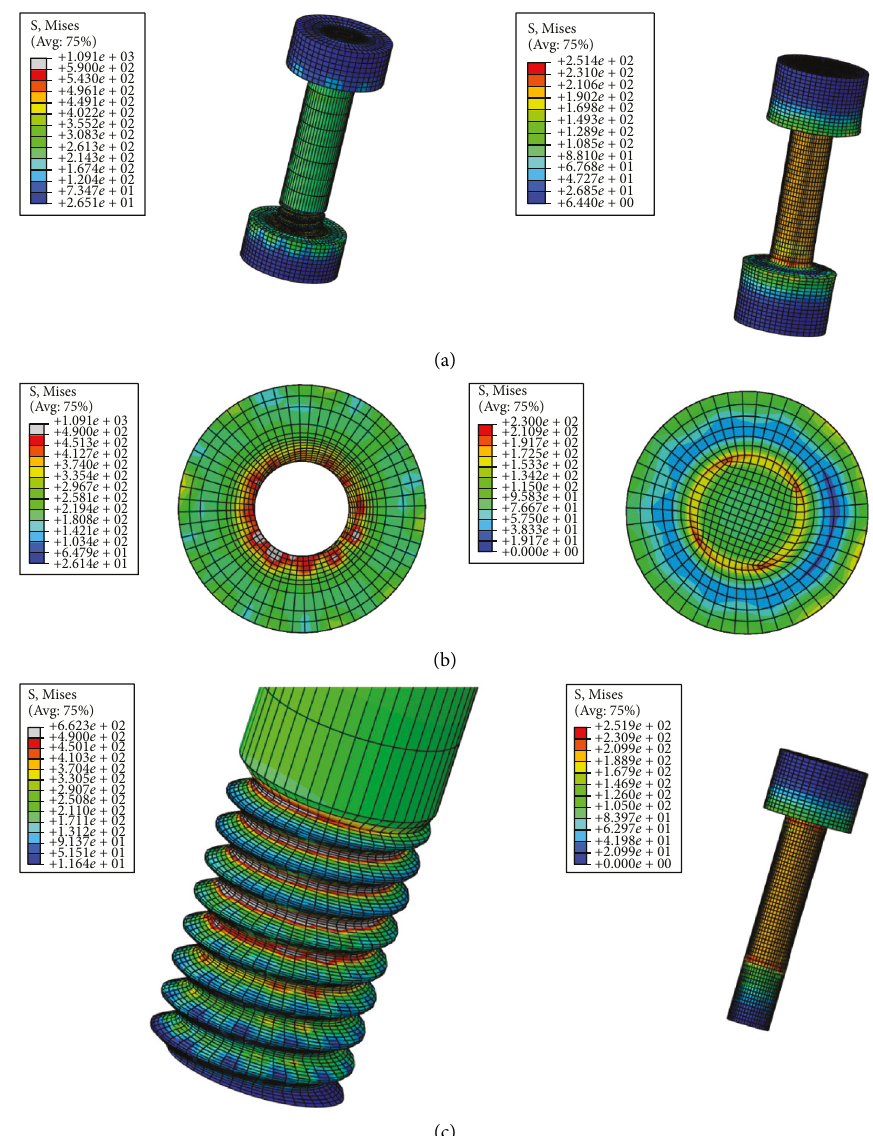
Figure 7: Stress comparison of two different preloaded models. (a) Overall bolt stress comparison (side view). (b) 7-nut stress comparison (vertical view). (c) Screw stress